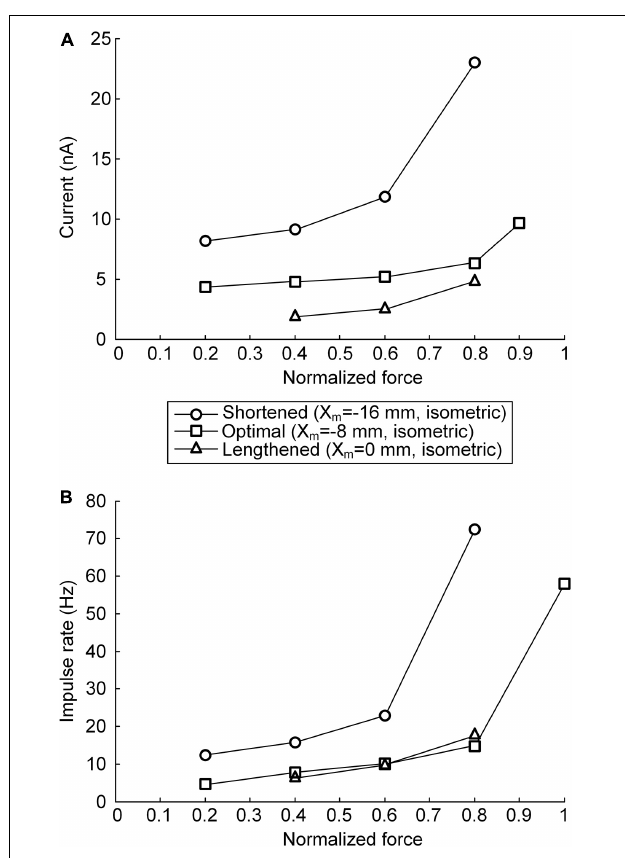
FIGURE 8 | Relationship between current stimulation and force genesis at the various muscle lengths. (A) Peak current amplitude eliciting the peak force during triangular force production under continuous stimulation conditions. (B) Peak impulse frequency eliciting the peak force during triangular force production under discrete stimulation conditions. The peak force is normalized based on the maximal force isometrically produced at the optimal muscle length. The three symbols (circles, squares, and triangles) indicate the physiological minimal ( X m = − 16 mm), optimal ( X m = − 8 mm), and maximal ( X m = 0 mm) muscle lengths,